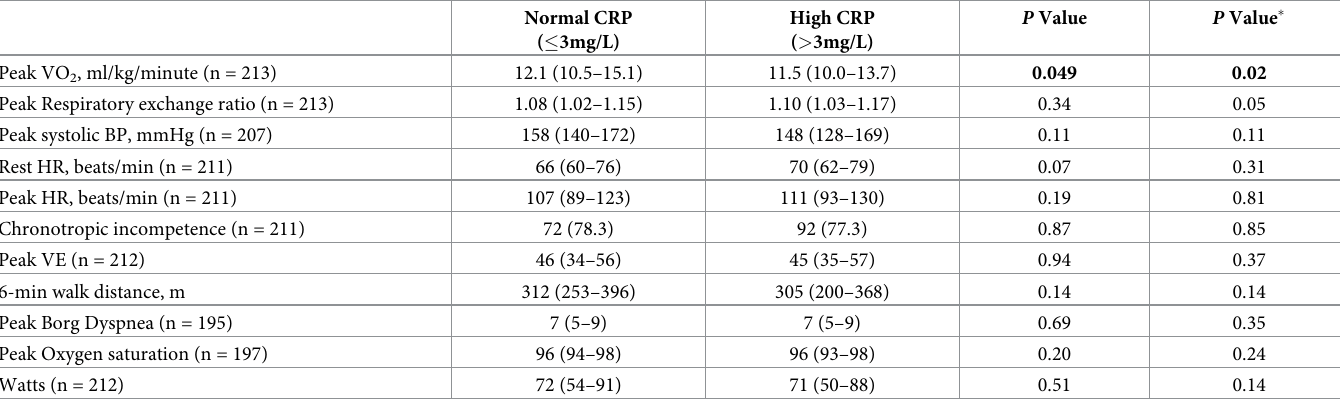
Table 3. Exercise performance by baseline C-reactive protein levels (CRP).